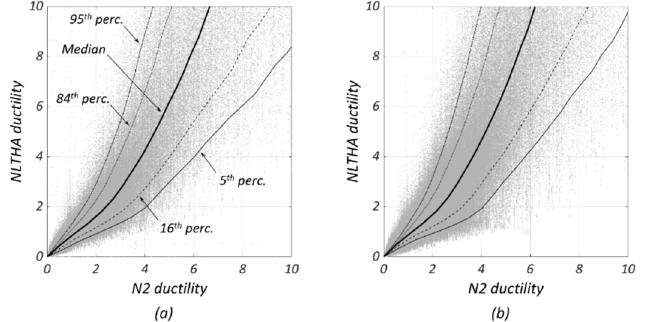
Figure 8. Comparison between ductility demands from the N2 method and from NLTHA: ( a ) Suite 1-A, and ( b ) Suite 1-B.